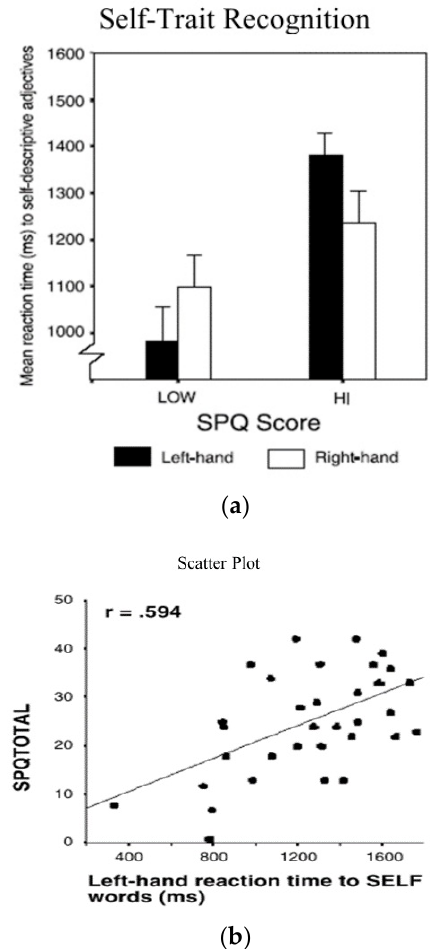
Figure 3. ( a ) Effects of SPQ scores on reaction times to self-trait words: ( b ) correlation between SPQ scores and left-hand reaction times to self-trait descriptors.